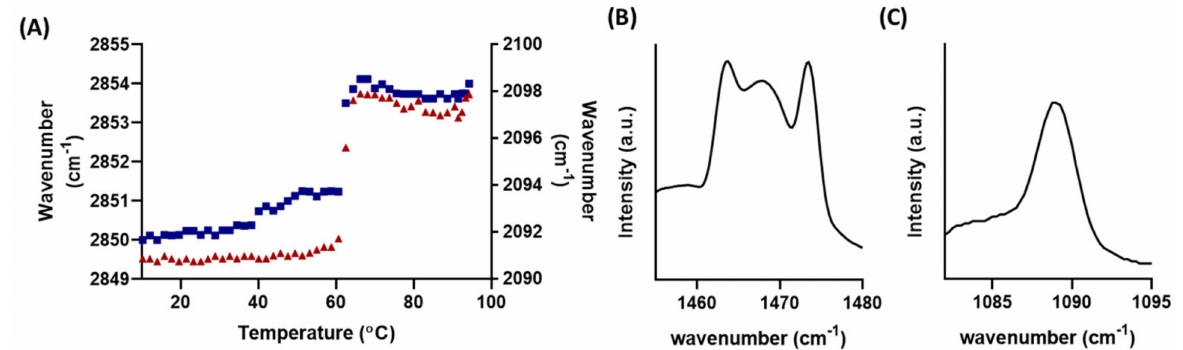
Figure 6. ( A ) Thermotropic response curves of ν s CH 2 (blue) and ν s CD 2 (red) of the 50% FFA C16 model. The CH 2 and the CD 2 peak positions are plotted on the primary and secondary y-axes respectively, displaying the phase transition temperatures of the protiated and dFFA C16 chains in the lipid models. ( B ) δ CH 2 and ( C ) δ CD 2 of the FFA C16 50% model, at 25 ◦ C. The composition of CERs, CHOL and FFAs are in an equimolar